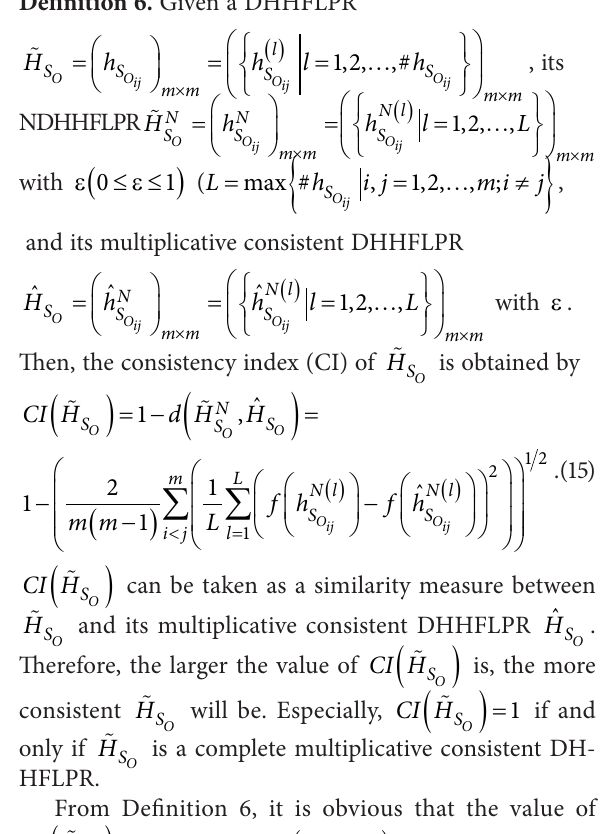
with respect to